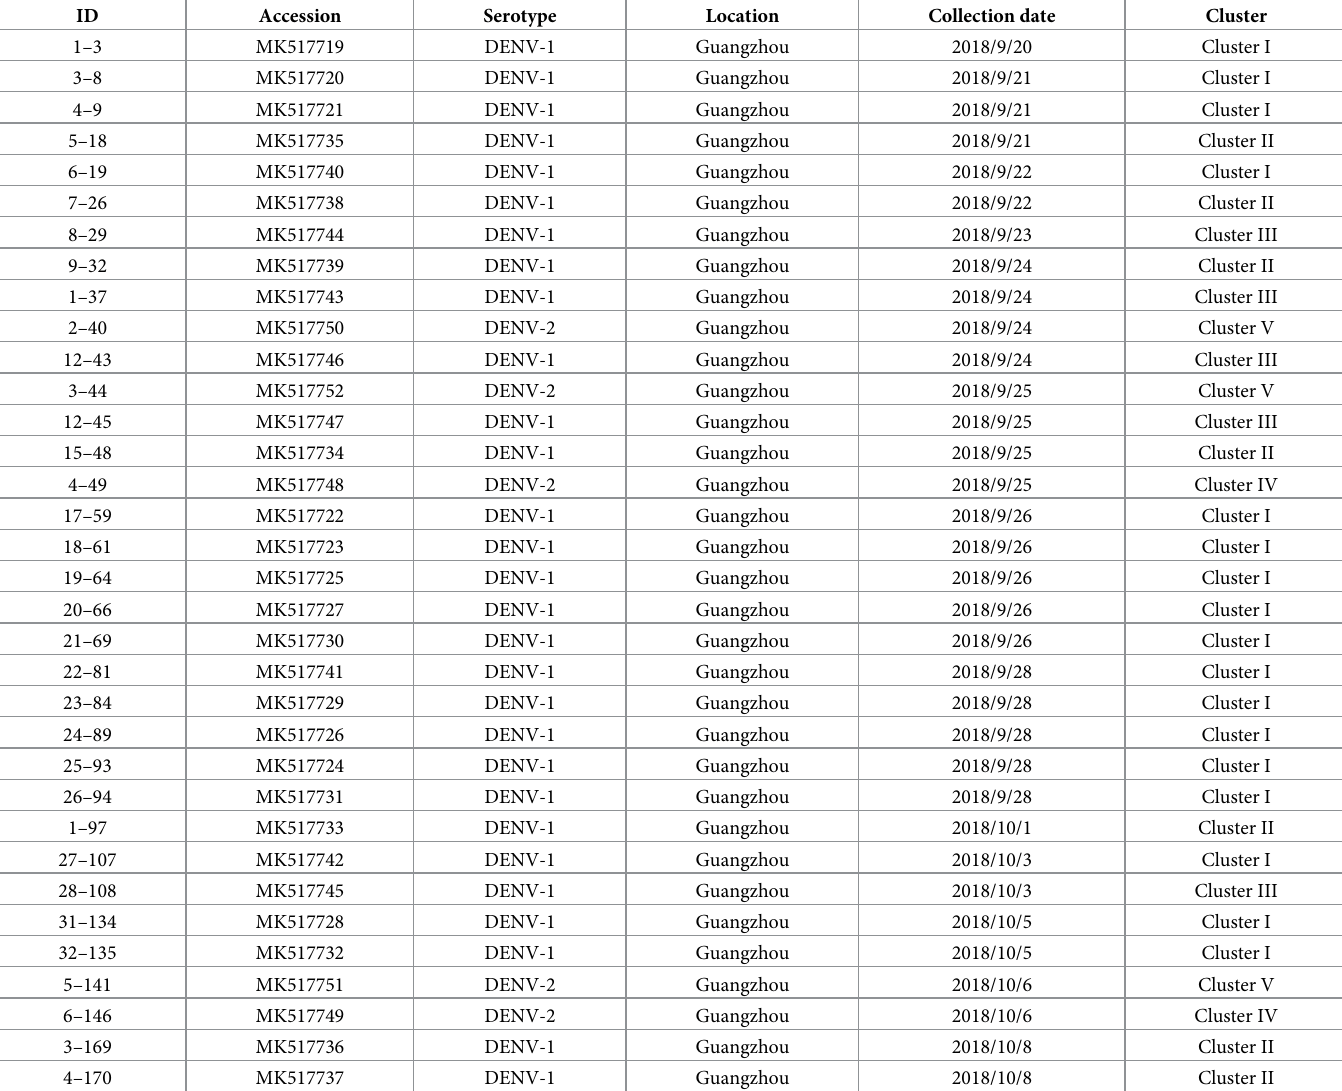
Table 3. The 2018 Guangzhou dengue virus sequences information isolated and uploaded in this study.